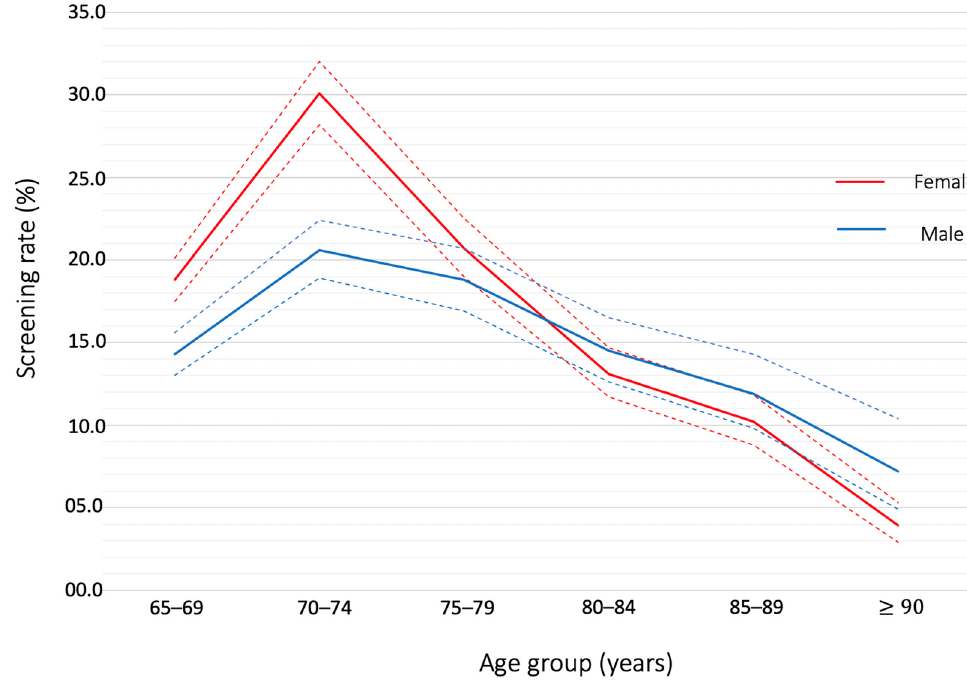
Figure 3. Atrial Fibrillation screening rates according to age group and gender. The continuous line represents the value of the screening rate in percentage and dotted lines show the upper and lower limits of the 95% confidence interval.